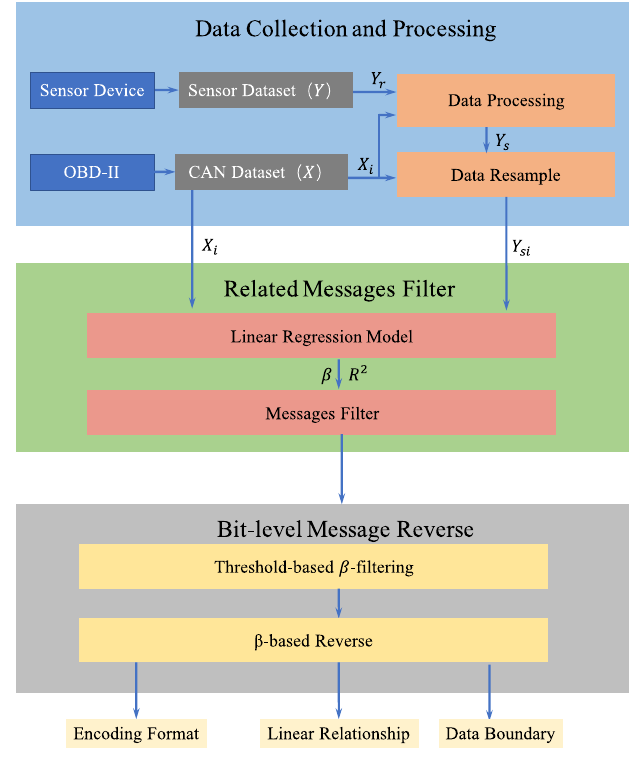
Figure 4. Overview of the framework.